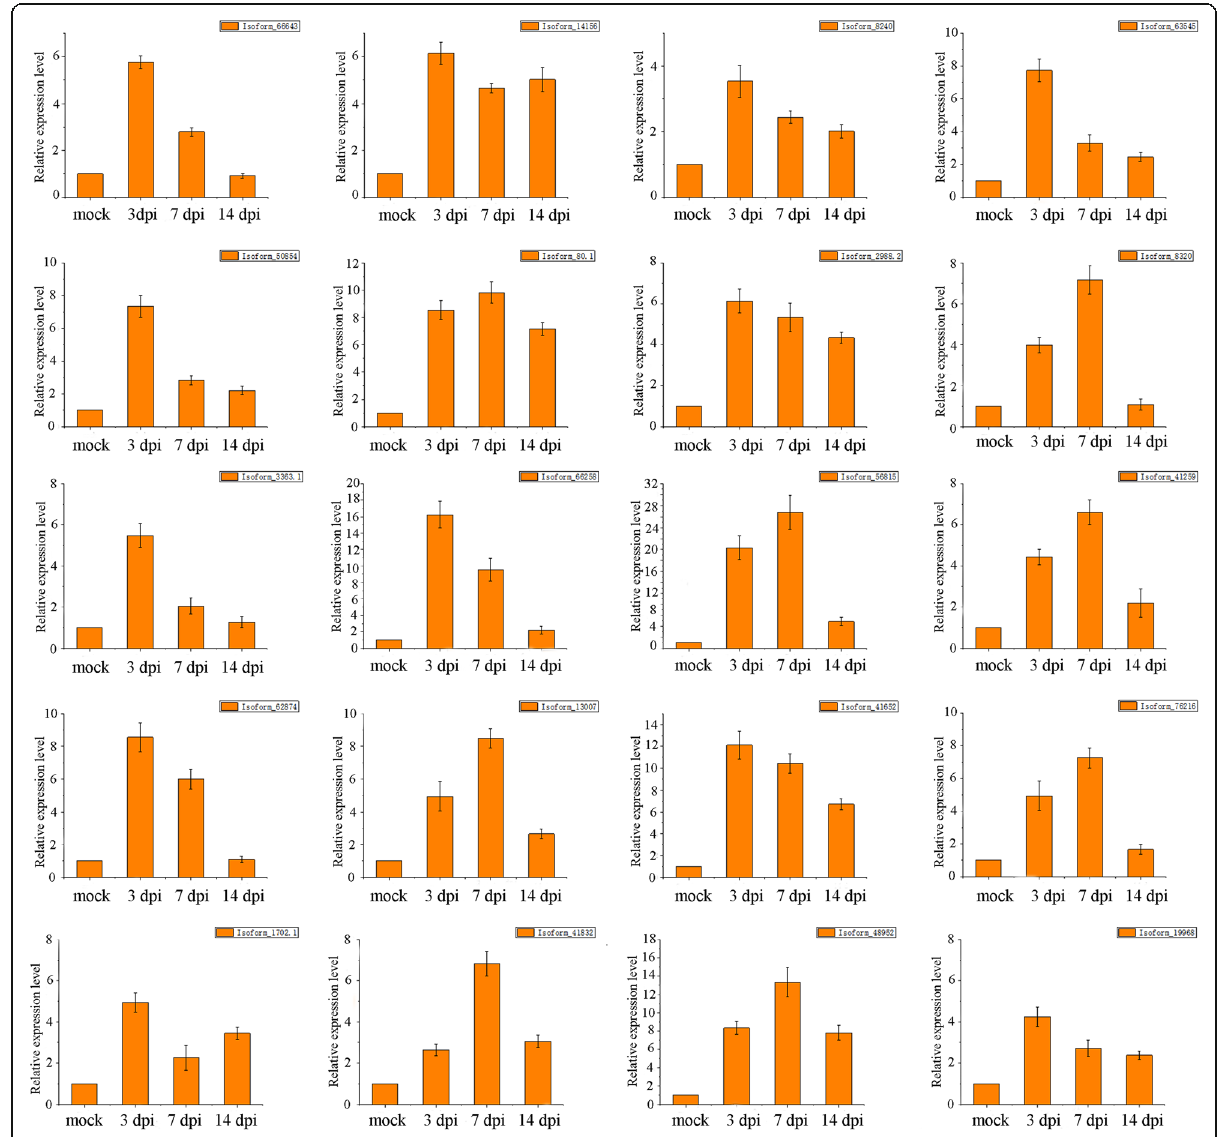
Fig. 8 Validation of the RNA-Seq results by RT-qPCR. Twenty DEGs were selected for RT-qPCR. The gene expression levels were normalized using the P. huashanica 18S rRNA gene as an internal reference. Error bars represent standard errors of three biological